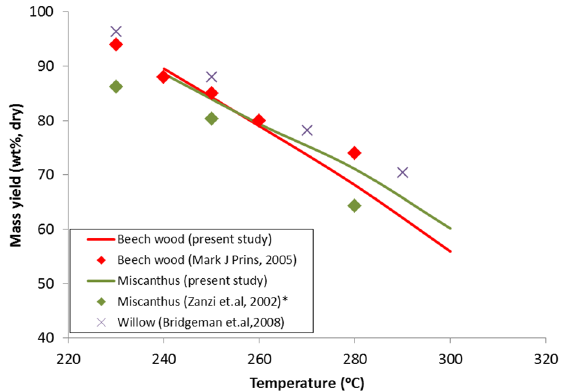
Figure 11. Mass yield profile versus torrefaction temperature for a residence time of 30 min for different biomass types. * For miscanthus torrefaction by Zanzi [11] the residence time (60